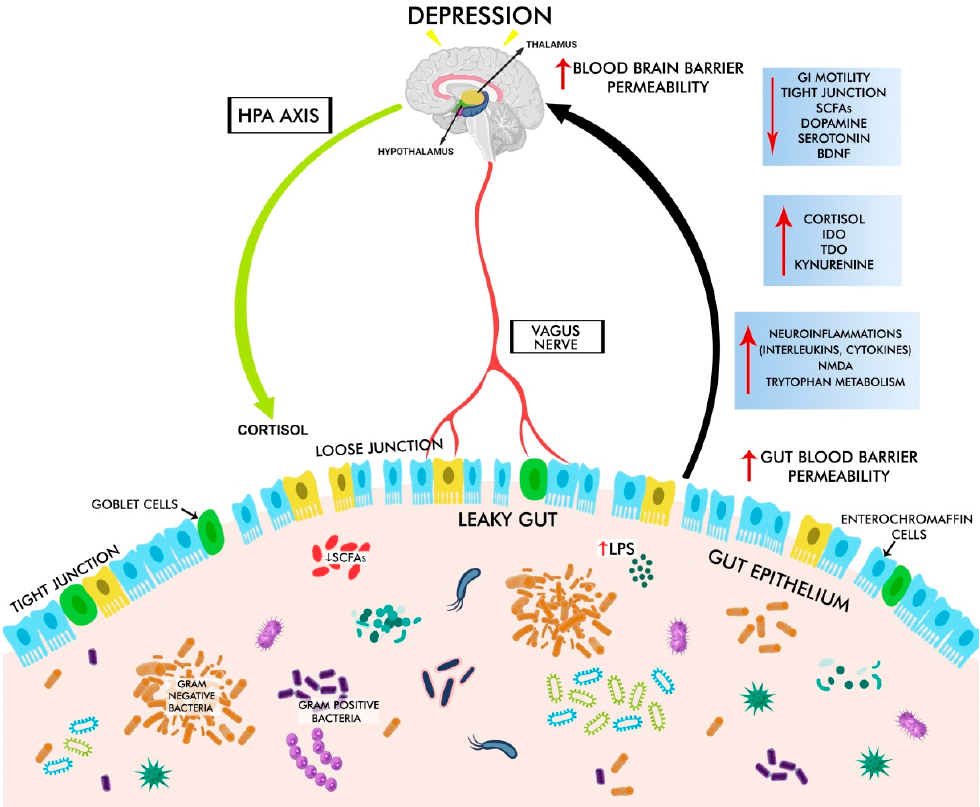
Figure 1. The gut–brain axis and depressive disorder. Gut dysbiosis increases intestinal barrier permeability, causing leaky gut with decreased levels of tight and adherent junction proteins, loss of goblet cells, increased lipopolysaccharide (LPS, an endotoxin derived from the Gram-negative bacterial cell wall), and increased blood–brain barrier permeability. These changes trigger the production of pro-inflammatory cytokines via HPA disruption and increased cortisol levels, which in turn leads to decreased levels of 5-HT and dopamine, BDNF, and IDO, TDO, kynurenine, resulting in depression.